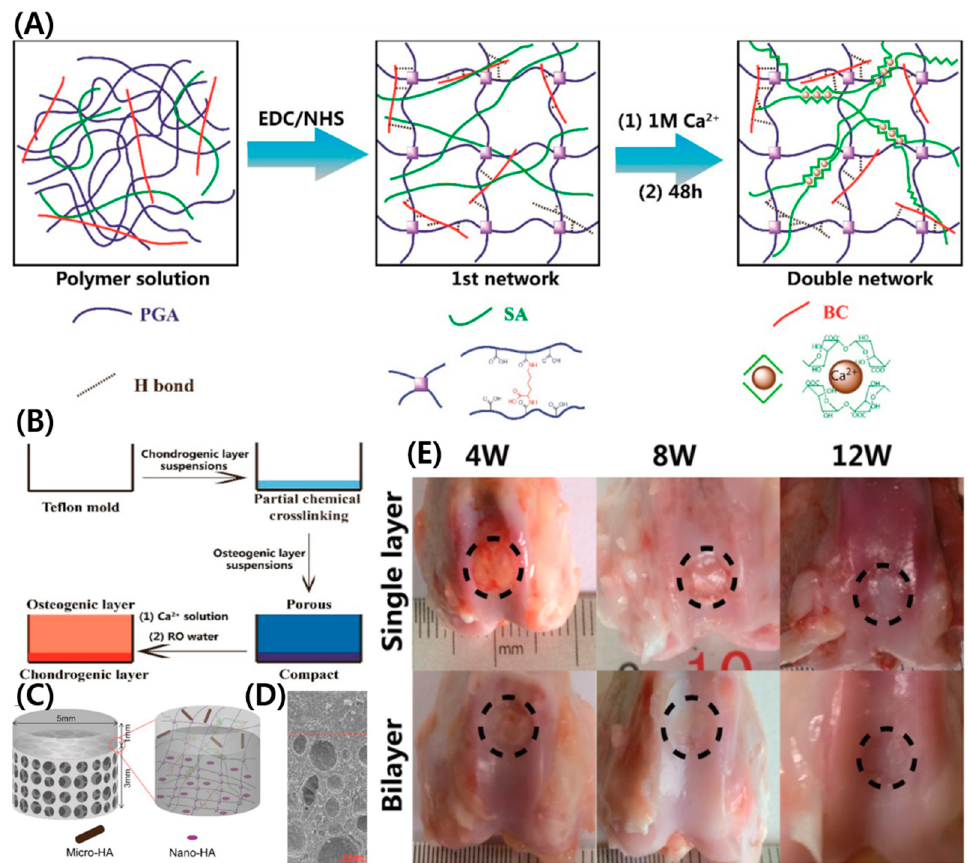
Figure 3. ( A ) Schematic representation of the formation of BC–DN hydrogel, ( B ) bilayered hydrogel, ( C ) structure illustration of bilayered hydrogel, ( D ) SEM image of bilayered BC hydrogel, ( E ) digital images of knees repaired at different timpoints. Reprinted with permission [71]. Copyright 2018 American Chemical